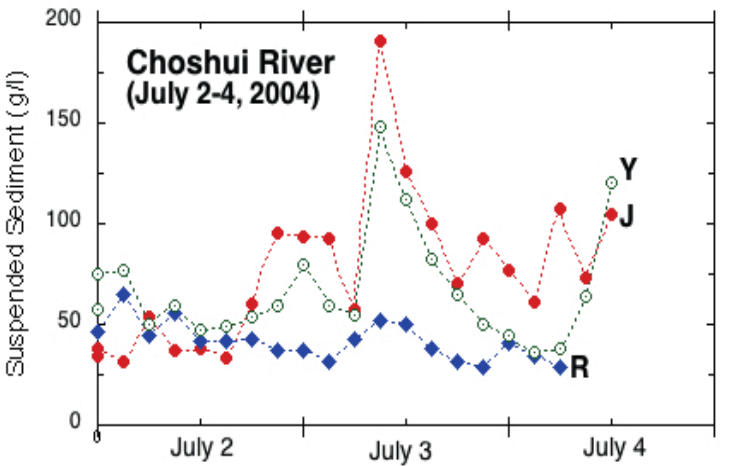
Fig. 5 Suspended sediment concentrations (g/L) at sampling stations J, Y and R during Typhoon Mindulle, 2–4 July 2004. of the 4th. Typhoon Aere measurements were restricted to Chunyun Bridge and Chinshui River stations; a total of 33 series of water samples were